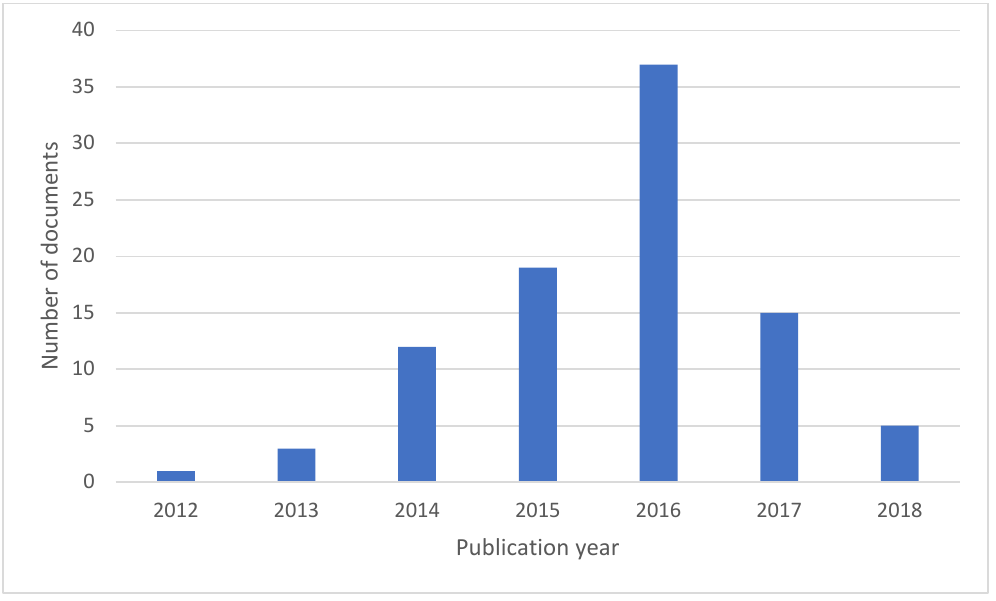
Figure 4. Documents by publication